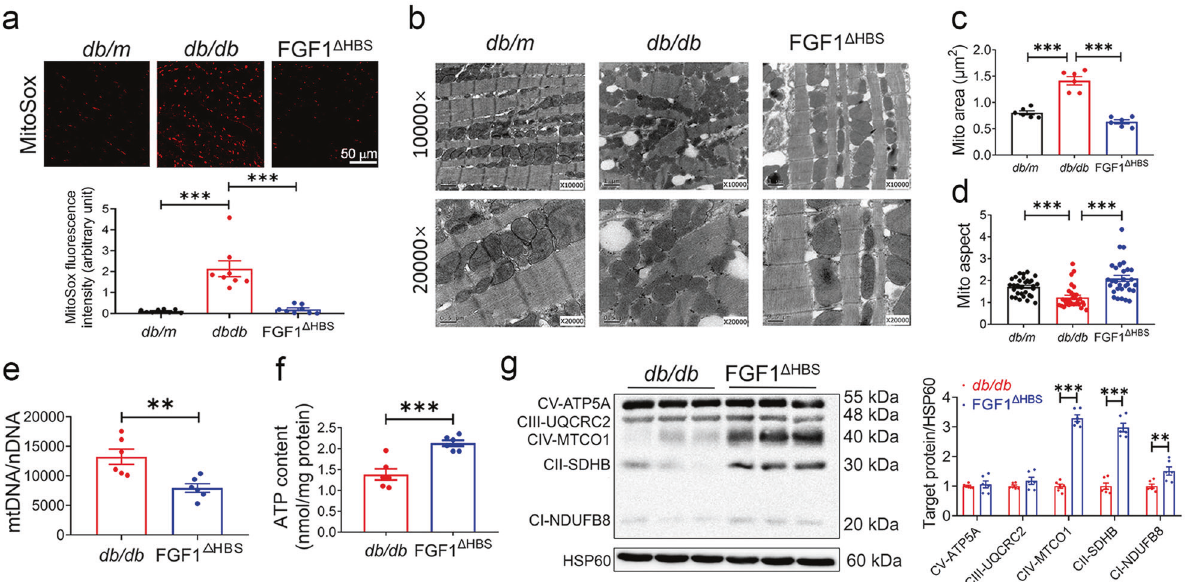
Fig. 4 FGF1 Δ HBS prevents mitochondrial ROS production and dysfunction in the hearts of db/db mice. a Representative images (upper panel) and quanti fi cation (lower panel) of fl uorescence intensity of MitoSox in cardiac tissues from db/db and db/db + FGF1 Δ HBS mice. n = 6. b Representative transmission electron micrographs of cardiac tissues in each group. c Mitochondrial area in cardiac tissues of each group. n = 6. d Mitochondrial aspect ratio (long/short axis) in the cardiac tissues. n = 30 – 31. e mtDNA copy number per nuclear genome in the cardiac tissues. n = 6. f ATP content in the cardiac tissues. n = 6. g Western blot analysis (left panel) and densitometric quanti fi cation (right panel) of mitochondrial respiratory complex in the cardiac tissues. HSP60 was a loading control. n = 6. Data were mean ± SEM; ** P < 0.01, *** P <